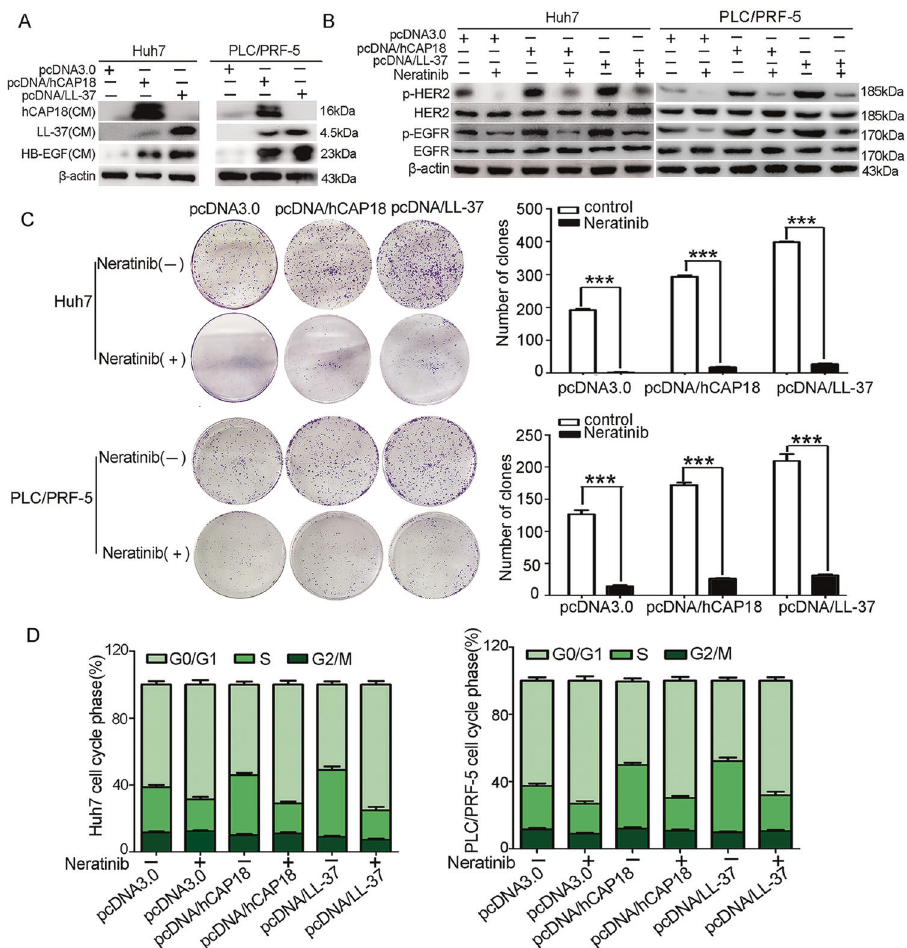
Fig. 4 hCAP18/LL-37 expression induces HB-EGF release and activation of EGFR/HER2 in HCC cells. A Huh7 and PLC/PRF-5 cells were transfected with pcDNA/hCAP18 or pcDNA/LL-37 for 48 h. HB-EGF in culture medium (CM) was detected by western blotting. B Huh7 and PLC/ PRF-5 cells were transfected with pcDNA/hCAP18 or pcDNA/LL-37 for 48 h, and then, western blot was conducted to detect the levels of p-EGFR (Tyr845) and p-HER2 (Tyr1248). Clone formation assay ( C ) and cell cycle assay ( D ) were conducted in Huh7 and PLC/PRF-5 cells with or without neratinib (3 μ M) after pcDNA/hCAP18 or pcDNA/LL-37 transfection. For cell cycle assay, cell proportion changes during different cell cycle periods were analyzed using PI staining. Data are presented as the mean ± SEM for 4 – 6 different experiments. *** p <